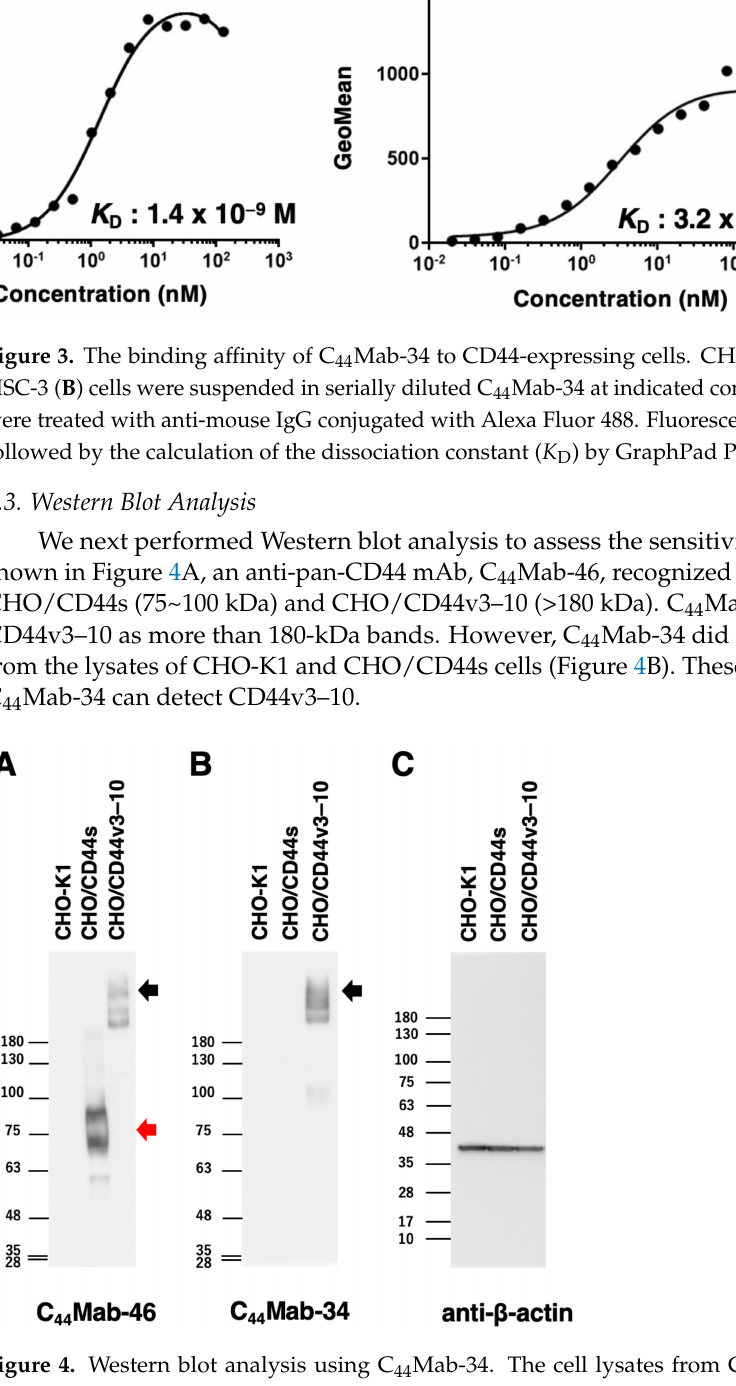
Figure 4. Western blot analysis using C 44 Mab-34. The cell lysates from CHO-K1, CHO/CD44s, and CHO/CD44v3–10 (10 µ g) were electrophoresed and transferred onto polyvinylidene fluoride (PVDF) membranes. The membranes were incubated with 10 µ g/mL of C 44 Mab-46 ( A ), 10 µ g/mL of C 44 Mab-34 ( B ), and 1 µ g/mL of an anti- β -actin mAb ( C ). Then, the membranes were incubated with anti-mouse immunoglobulins conjugated with peroxidase for C 44 Mab-46, C 44 Mab-34, and an anti- β -actin mAb. The red arrows indicate the CD44s (75~100 kDa). The black arrows indicate the